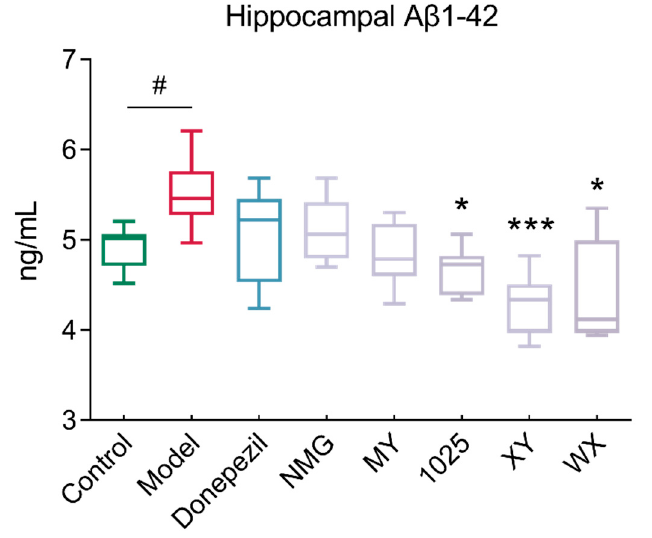
Figure 3. Changes in A β 1-42 levels in the hippocampal homogenates of mice in different groups ( n = 6–8). In the box plot, the bottom and top are, respectively, the 25th and 75th percentile; a line within the box marks the median. Whiskers above and below the box indicate the 1.5 interquartile range of the lower and upper quartile, respectively. Control vs. Model: # p < 0.05 by unpaired student’s t -test; * p < 0.05, *** p < 0.001 by one-way ANOVA for all